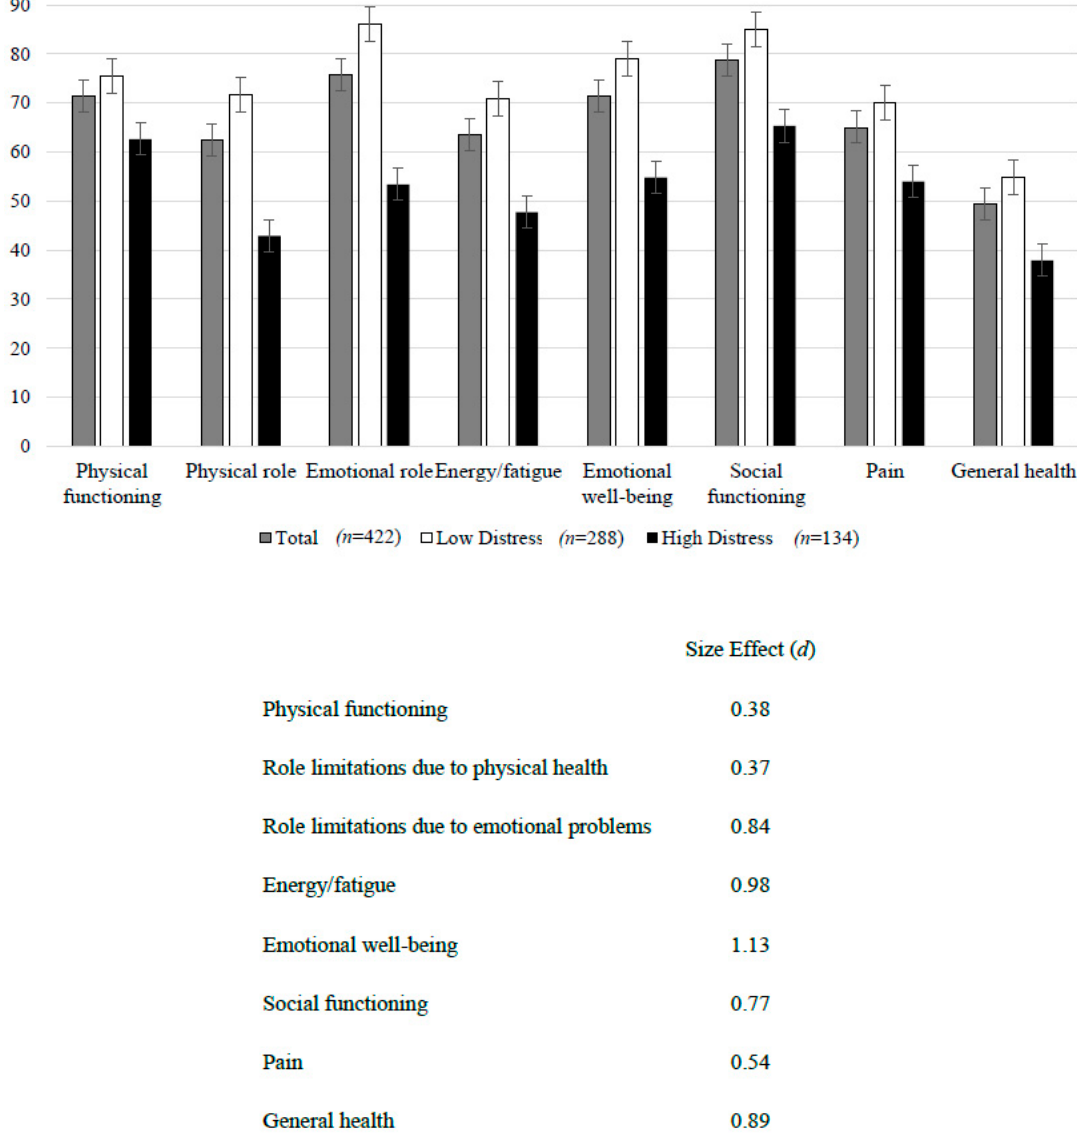
Figure 1. Health-related quality of life dimensions according to emotional distress status.